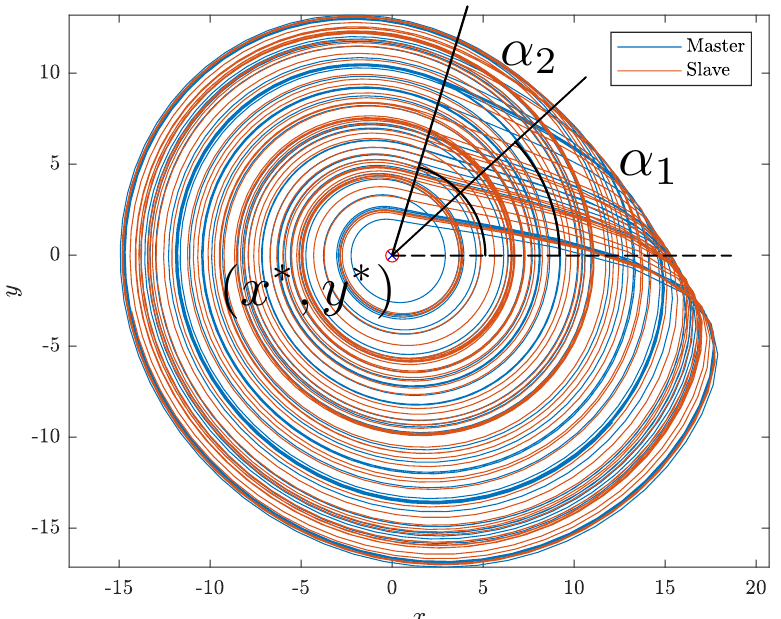
Figure 1. Phase portraits of chaotic attractors of the master and slave Rössler oscillators. They both share the center coordinates ( x ∗ , y ∗ ) . The relative phase of each oscillator is represented by α 1 and α 2 angles calculated by Equation